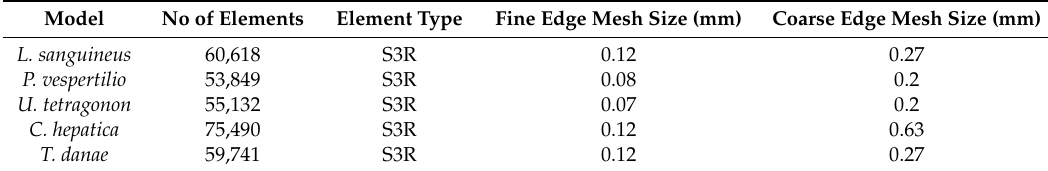
Table 1. Mesh specifications for each model.